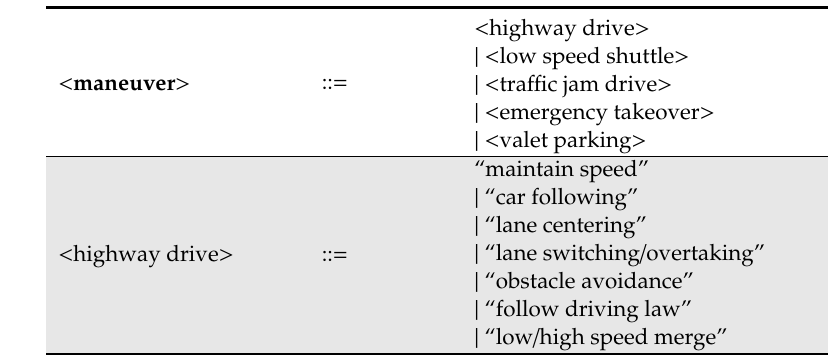
Table A2. The 1st and 2nd stages of < maneuver >